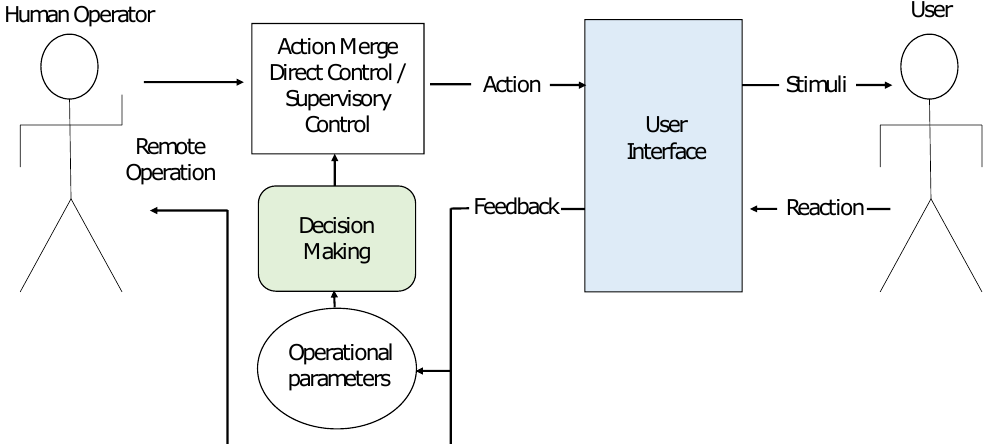
Figure 9. A schematic of the general architecture of a teleoperation system that includes an adap- tive system.